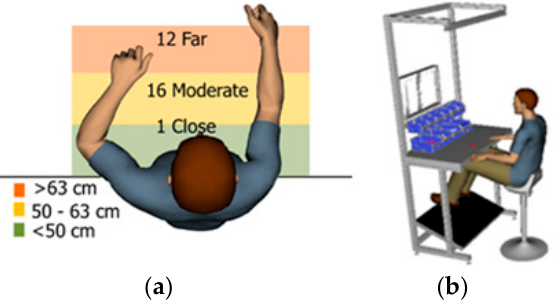
Figure 10. ( a ) Distribution of forward reaches per work cycle on traditional assembly workstation; ( b ) computer-aided design (CAD) model of a traditional workstation with an avatar in a virtual